Question: Sum up the contents of this chart in one sentence.
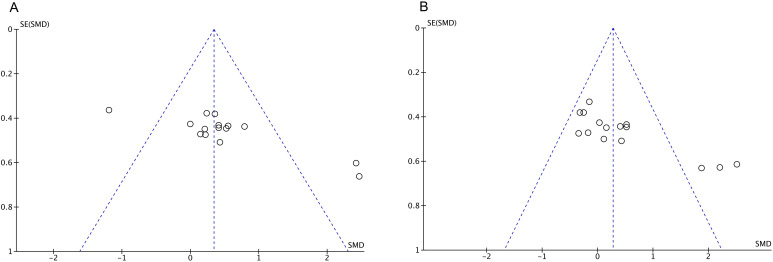
Answer: Funnel plots of included literature: (A) cortical excitability funnel plot; (B) motor performance funnel plot.